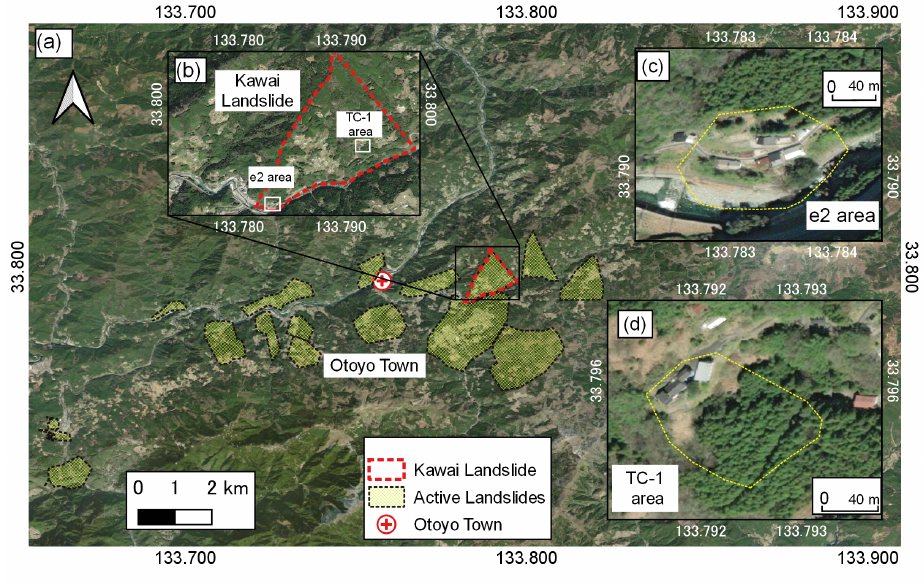
Figure 2. Map of the active landslide in Otoyo Town ( a ), the Kawai landslide ( b ), and the channels of the Kawai landslide; e2 area ( c ) and TC-1 ( d ). The two channels of the Kawai landslide were monitored by using anchor pressure and borehole inclinometer surveys (presented in Figures 3 and